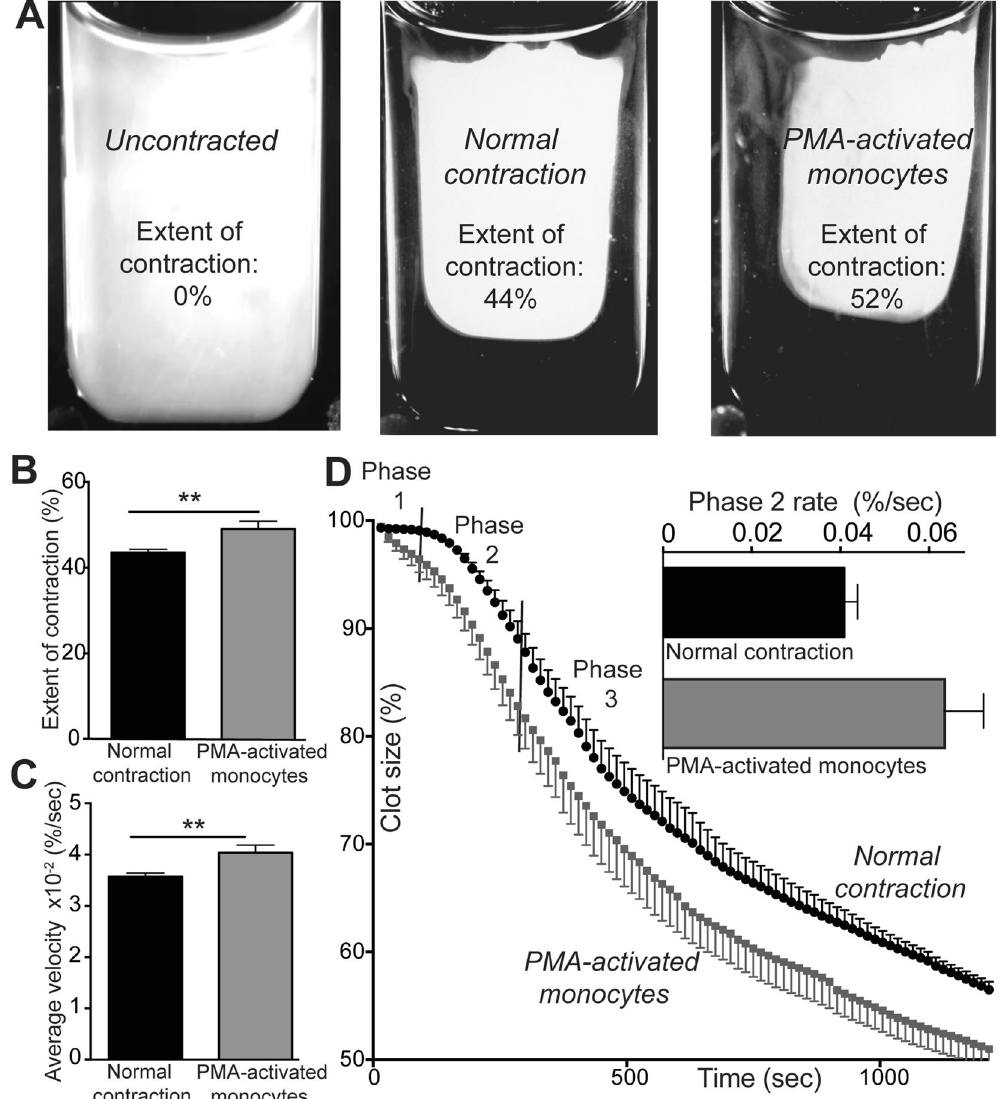
Figure 1. Effects of activated monocytes on clot contraction. Isolated non-activated monocytes or PMA- activated monocytes were supplemented to whole citrated blood. Clotting and clot contraction were initiated with 2 mM CaCl 2 and 1 U/ml thrombin followed by optical tracking of clot size. ( A) Representative raw images showing an initially uncontracted clot and clots after 20-minute contraction obtained from the same blood sample under standard experimental conditions after addition of non-activated and PMA-activated monocytes. ( B ) Average extent of clot contraction and ( C ) average velocity of contraction at 20 minutes, determined after addition of non-activated and PMA-activated monocytes (n = 8). ( D ) The averaged kinetic contraction curves (n = 8) with and without monocyte activation were used to determine the rates of the three phases of clot contraction separated by the vertical lines. Insert – the comparative rates of Phase 2. The results are presented as mean ± SEM. ** p <